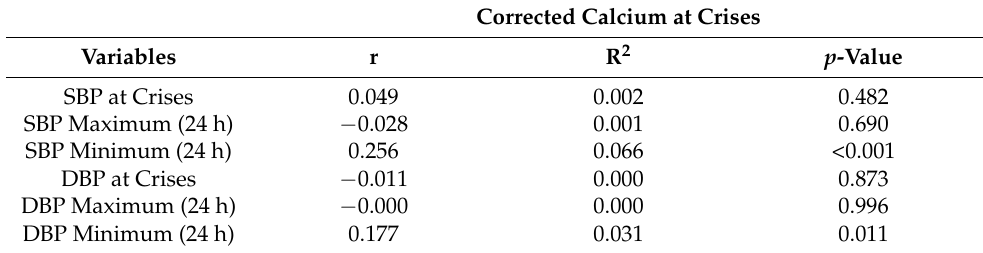
Table 8. Association of corrected calcium at crises with SBP and DBP at different time points ( N = 207). Corrected Calcium at Crises